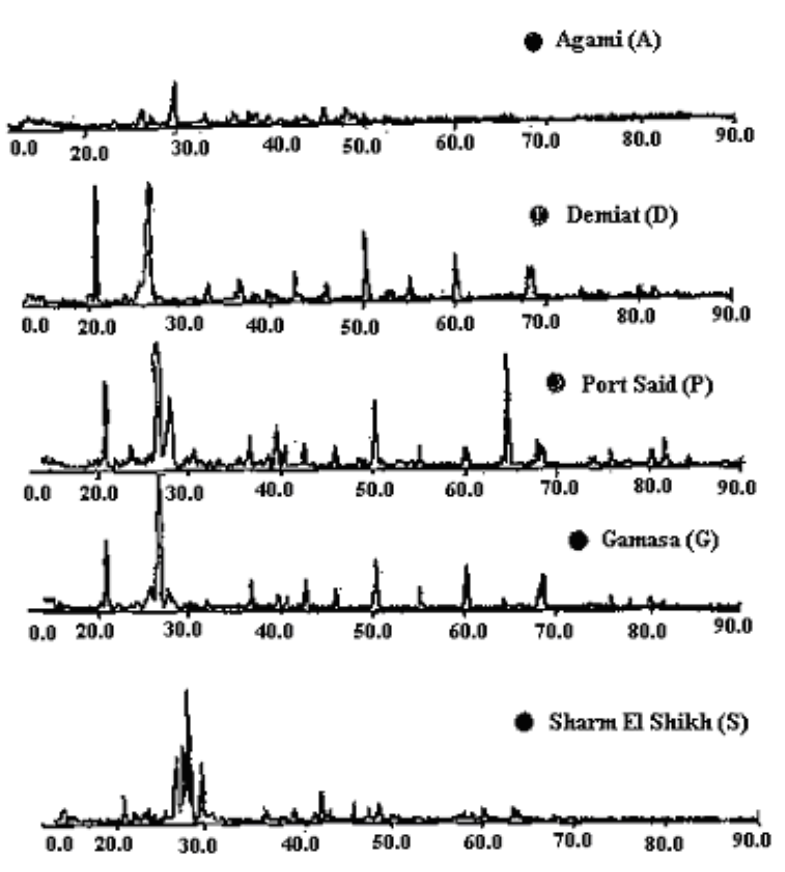
FIGURE 2 . X-ray defraction of the marine sediment samples. Agami (A), Damietta (D), Port Said (P), Gamasa (G), and Sharm El- Sheikh (S).